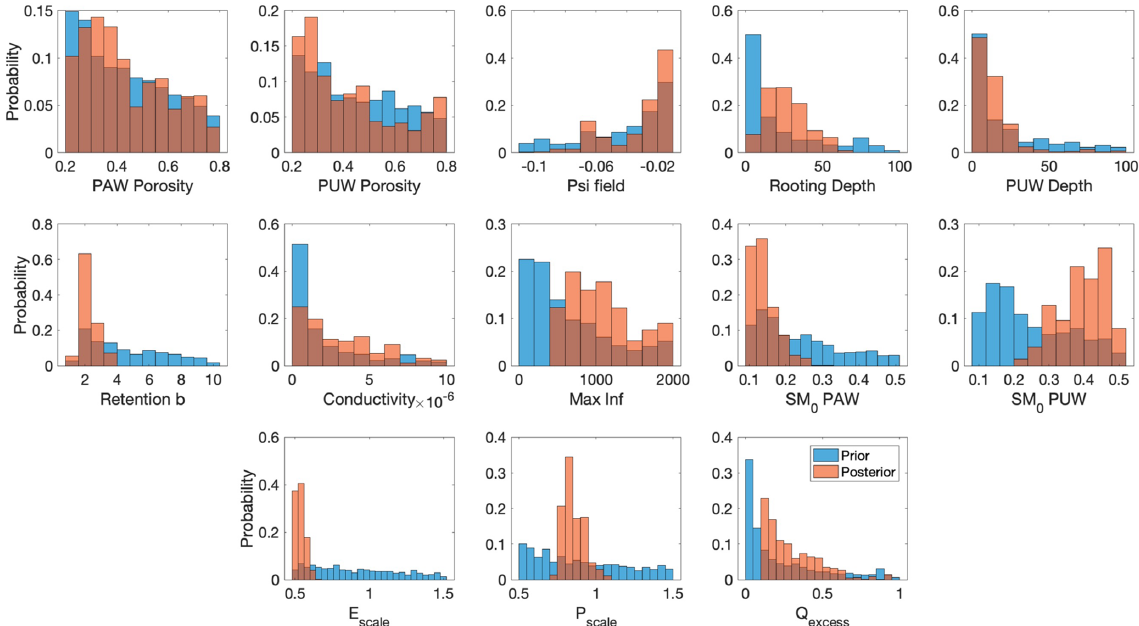
Figure 3. Histograms of the prior (blue) and posterior (orange) distributions of the GRACE-informed parameters for the Gavião watershed.